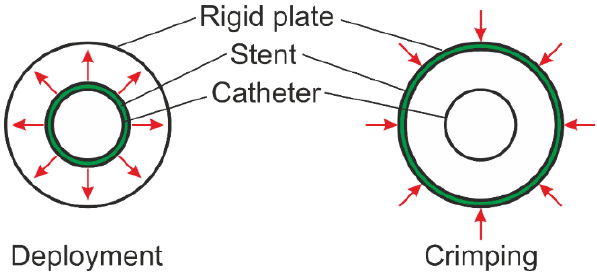
Figure 2. Diagram presenting the procedure during numerical simulations .